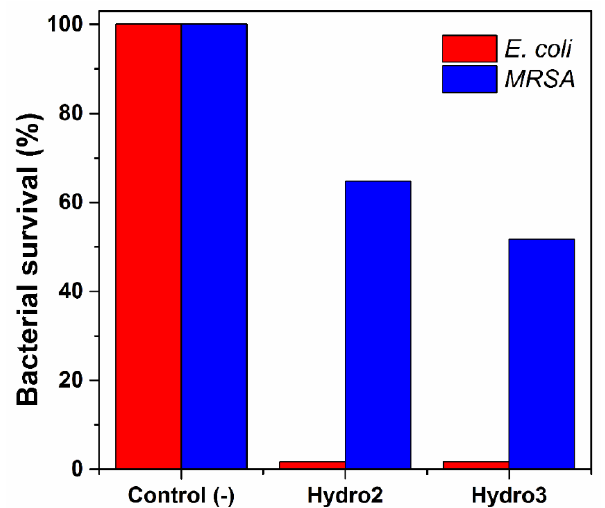
Figure 10. Antimicrobial activity of hydrogels challenged against E. coli and S. aureus strains.